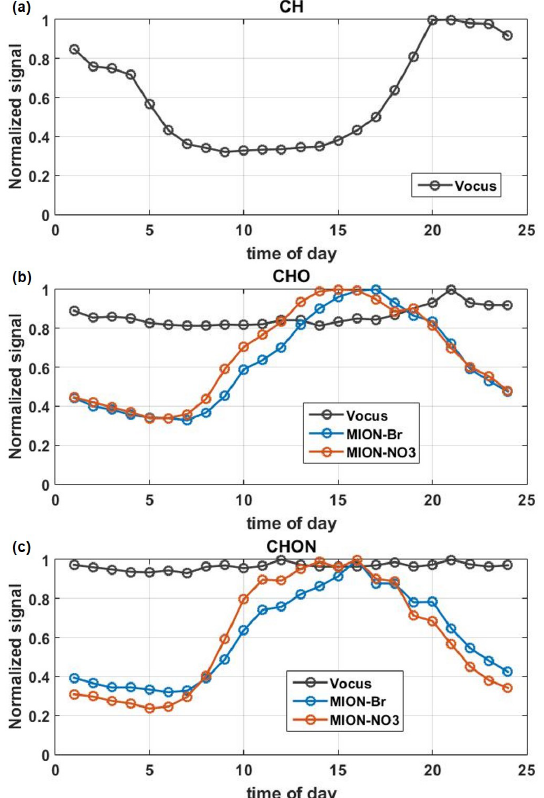
Figure 4. The median diurnal patterns of the total CH compounds measured by Vocus (a) , CHO (b) , and CHON compounds (c) mea- sured by Vocus, MION-Br, and MION-NO 3 during the whole mea- surement period. Signals were normalized to their maximum